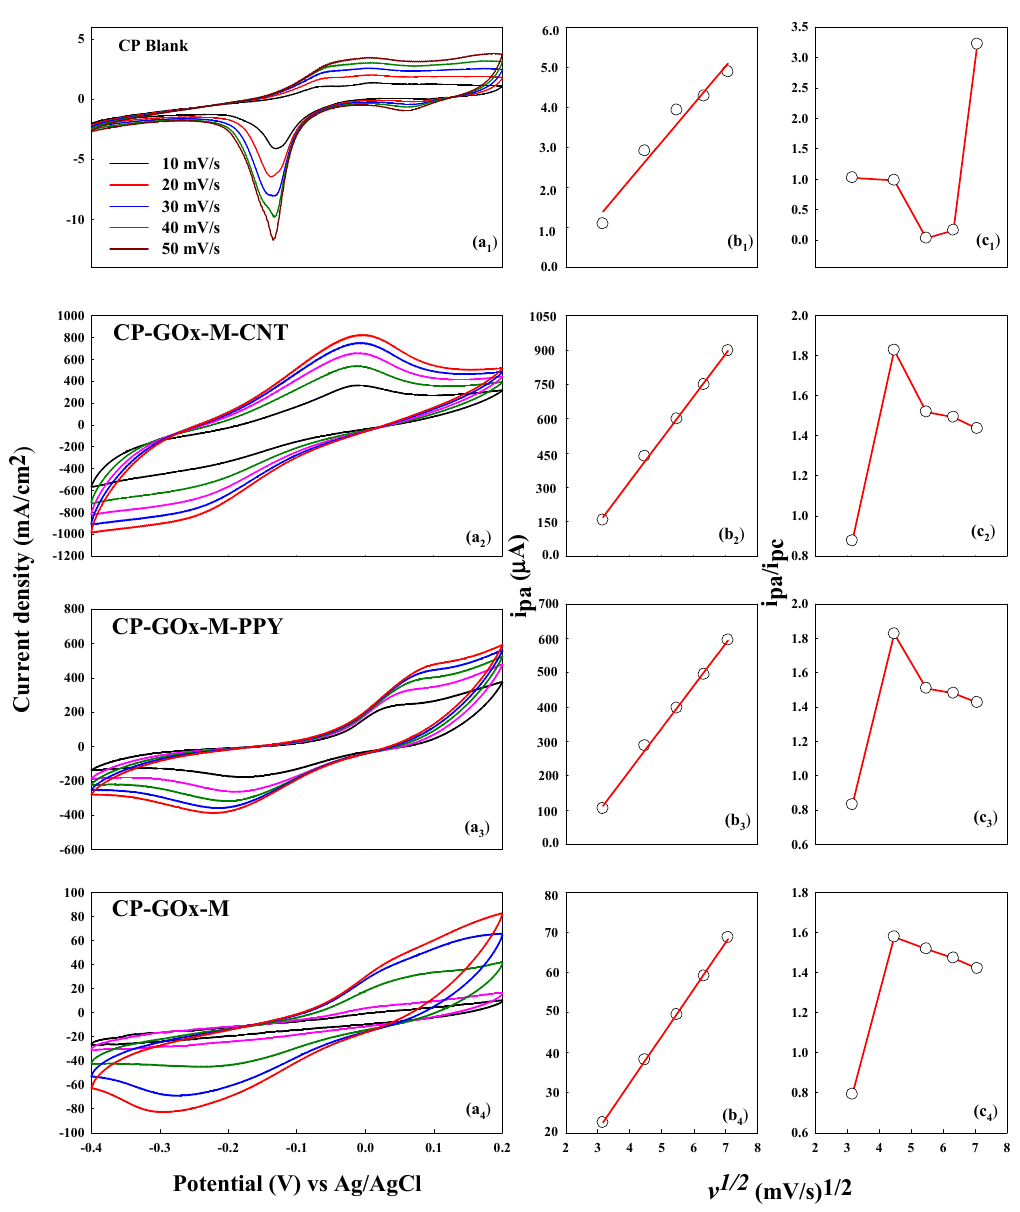
Figure 1. ( a 1 – a 4 ) Cyclic voltammogram for the blank electrode and bioanode electrode with different combinations at different scan rates, 10–50 mV/s, ( b 1 – b 4 ) i pa in proportion to the square root of the scan rates, and ( c 1 – c 4 ) ratio of i pa :i pc to the square root of the scan rates.